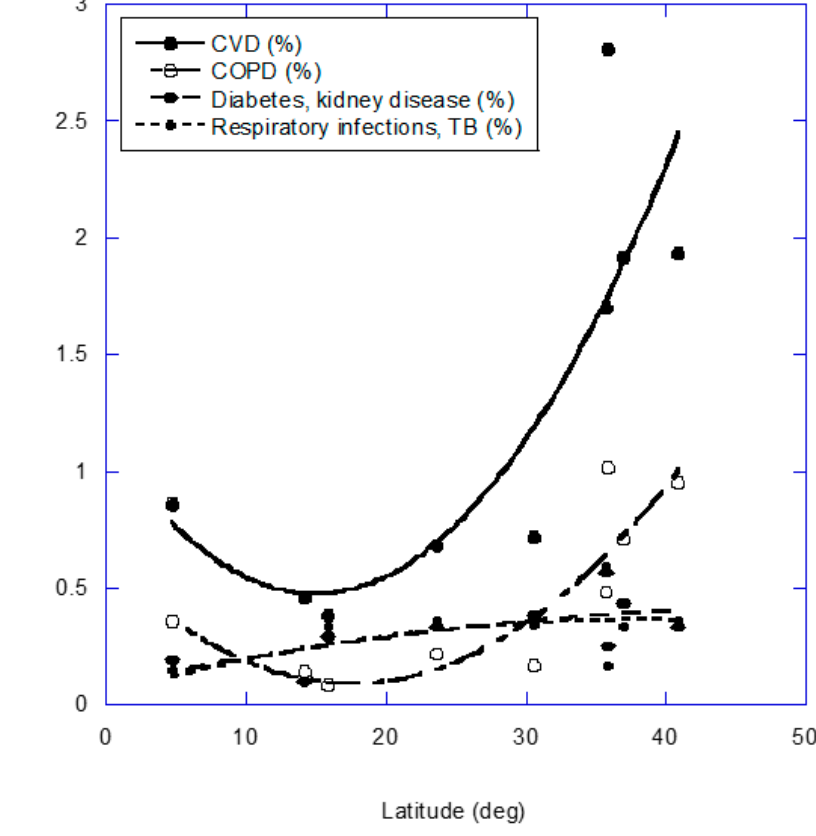
Figure 4. Percentage of deaths attributable to low temperatures for cardiovascular disease (CVD), chronic obstructive pulmonary disease (COPD), diabetes, kidney disease, respiratory infections and tuberculosis (TB) versus absolute latitude (doi:10.1016/S0140-6736(21)01700-1) [3]. The regression fits are second-order.